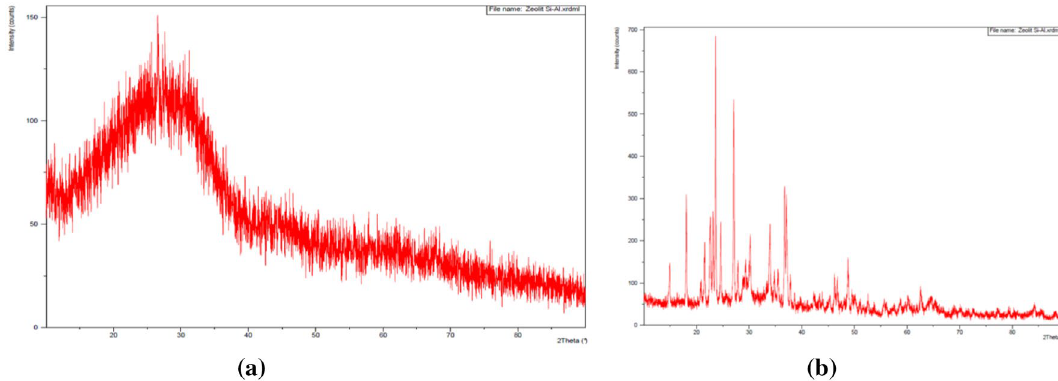
Figure 10. Amorphous silica (without N-CTMABr) ( a ) and crystalline silica (with NCTMABr) ( b ).